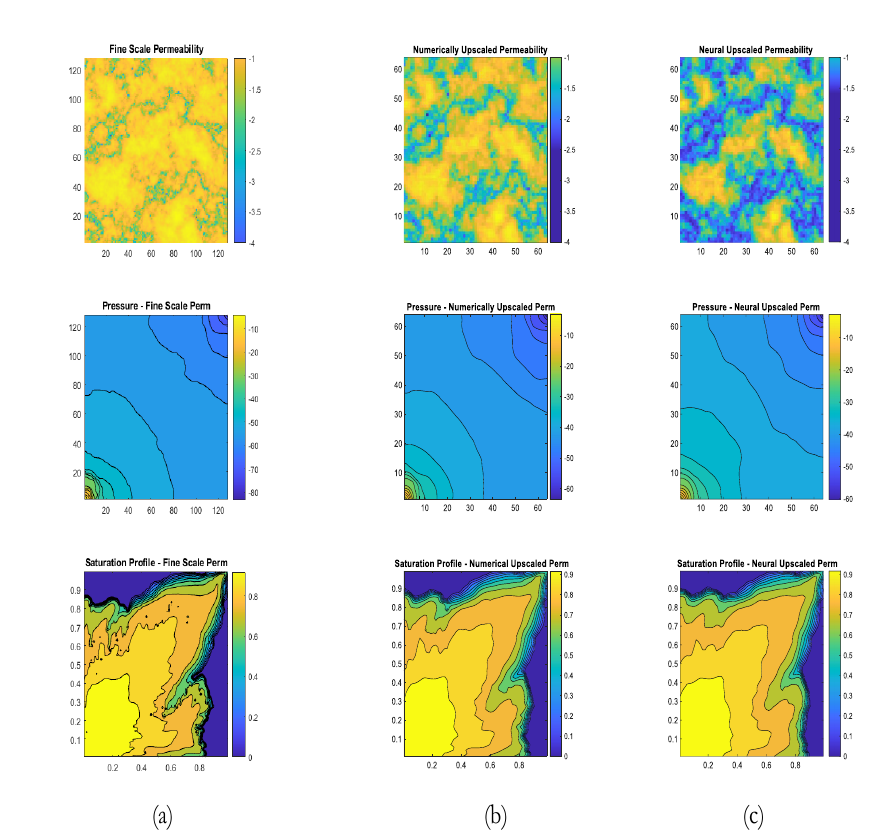
Figure 19. ( a ) Figure showing Fine Scale Permeability on 128 × 128 × 1 grid, Fine Scale Pressure and Saturation Profiles for Quarter-5-spot pattern injection. ( b ) Figure showing Numerically Upscaled Permeability on 64 × 64 × 1 grid, Upscaled Pressure and Saturation Profiles for Quarter-5-spot pattern injection. ( c ) Figure showing Neural Upscaled Permeability on 64 × 64 × 1 grid, Upscaled Pressure and Saturation Profiles for Quarter-5-spot pattern